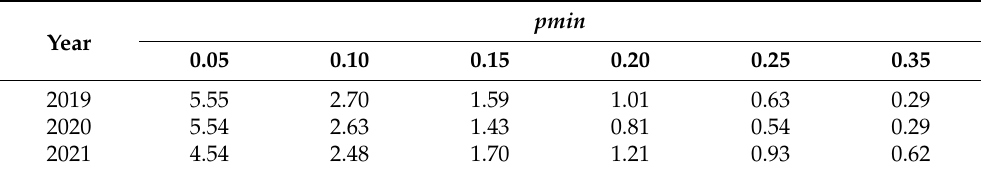
Table 3. Average number of preferred restaurants according to the value of the parameter pmin .